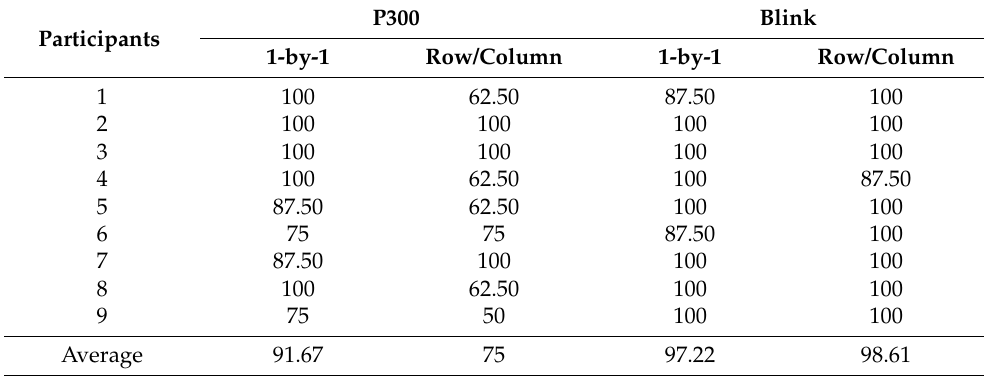
Table 3. Classification accuracy (in %) for each subject, stimulation paradigm and control